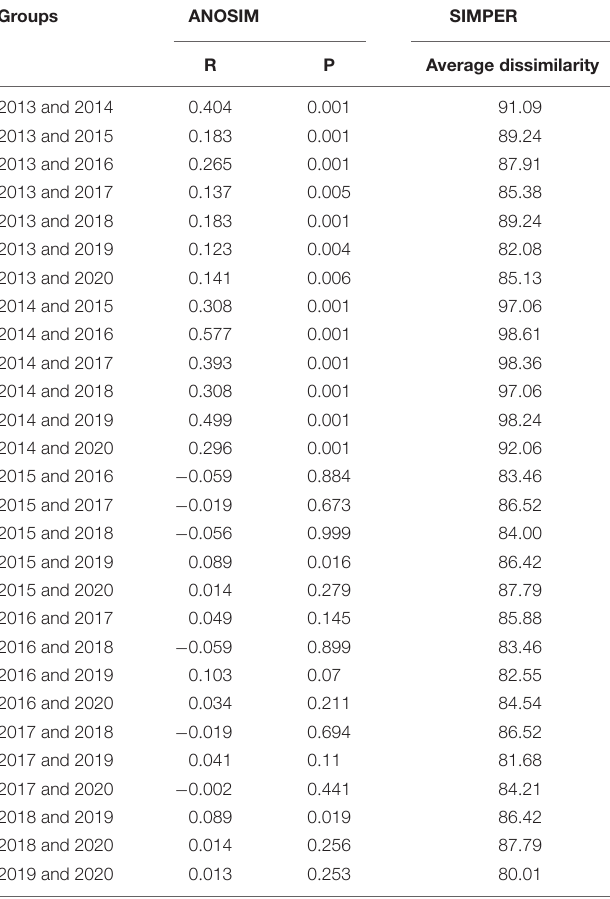
TABLE 3 | Inter-annual comparison of the assemblage structure according to one-way ANOSIM (R value and significance level) and SIMPER analysis. Groups ANOSIM